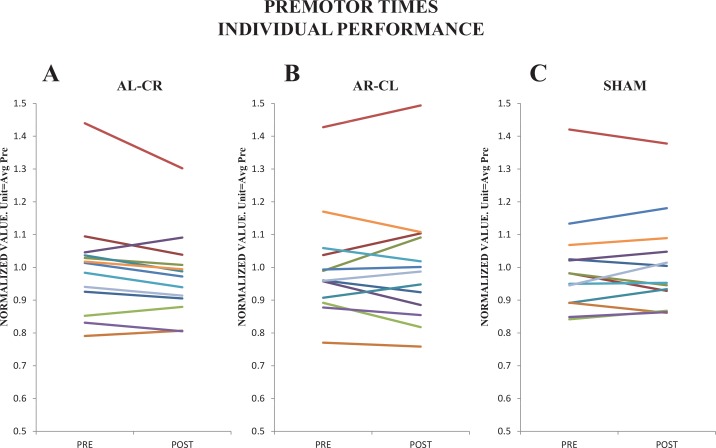
Individuals’ responses for PMT.The y-axis unit indicates the mean response considering all subjects and conditions at Pre. It was equivalent to 201.8ms (sem 11.5) for AL-CR (A); 204.5ms (sem 12.3) for AR-CL (B); and 201.0ms (sem 10.5) for Sham sessions (C).